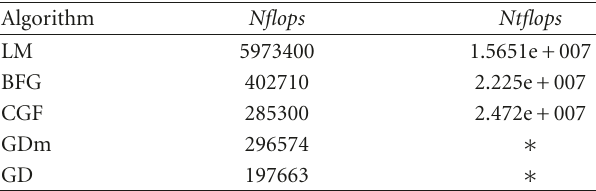
Table 1: Computation comparison for di ff erent algorithms.